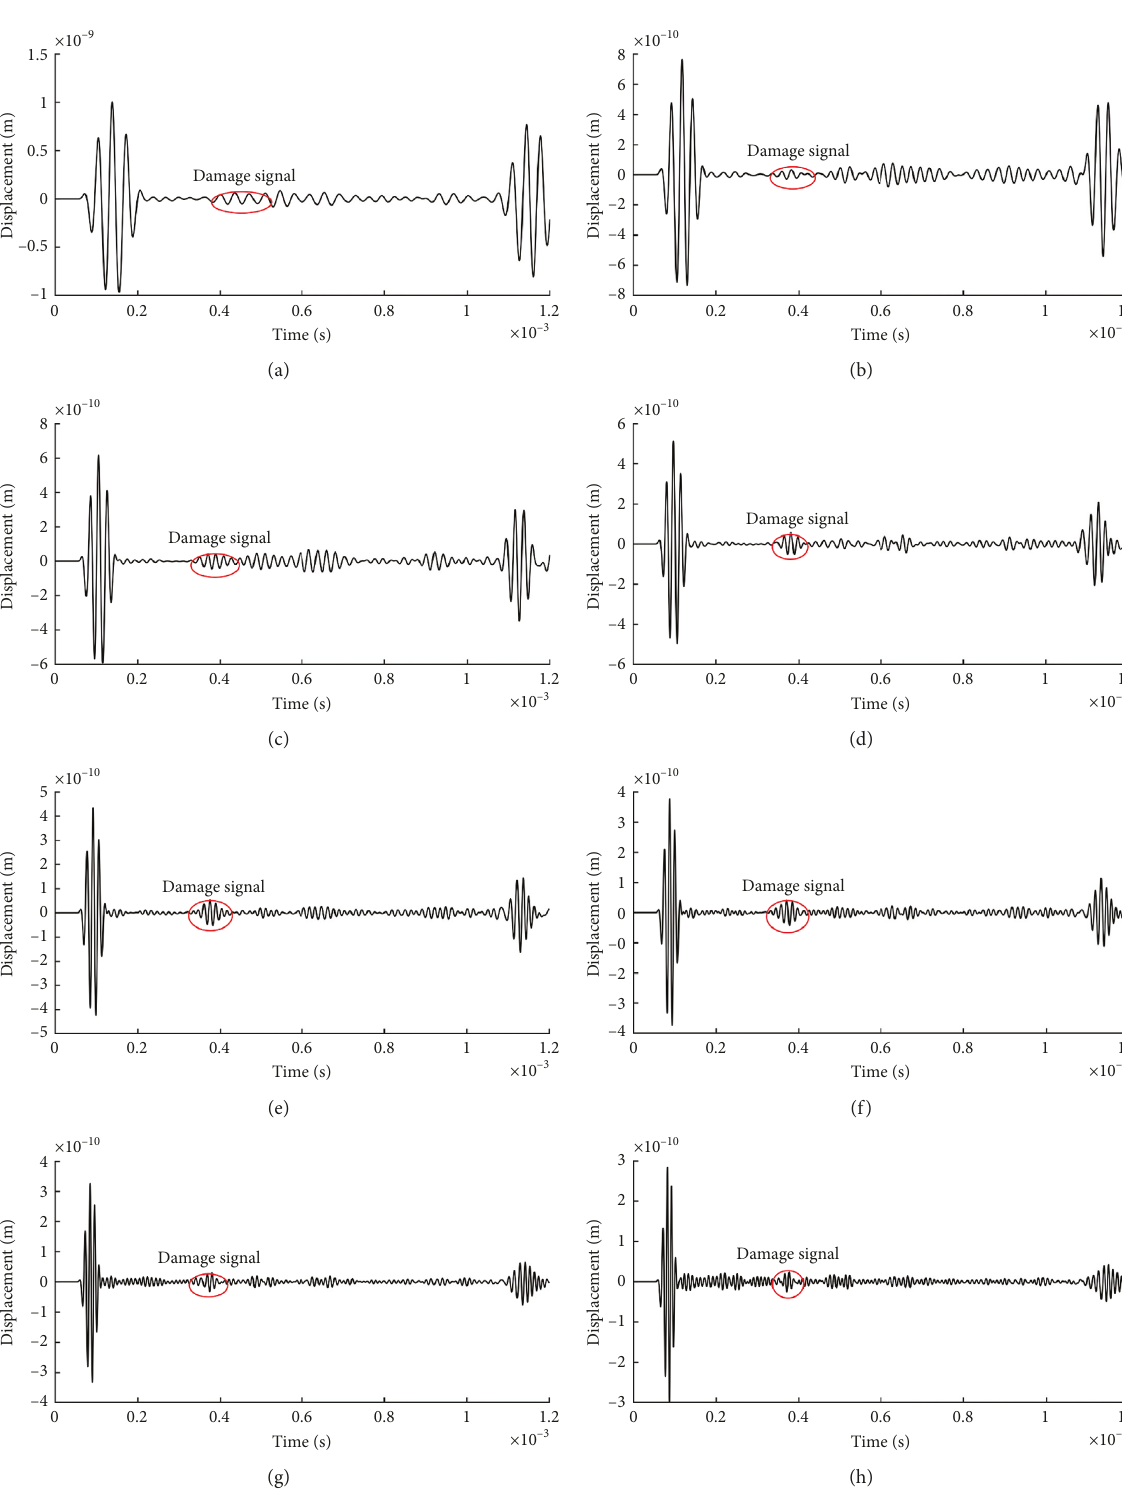
Figure 6: Time domain diagram of guided waves in single-defective sections at different excitation frequencies. (a) 30kHz guided wave signal; (b) 40kHz guided wave signal; (c) 50kHz guided wave signal; (d) 60kHz guided wave signal; (e) 70kHz guided wave signal; (f) 80kHz guided wave signal; (g) 90kHz guided wave signal; (h) 100kHz guided wave signal of the far-end defect gradually decreases and the cylindrical guided wave propagation is inversely gradually approaches the amplitude of the reflected echo proportional to the square of the distance. As the relative signal of the near-end defect. distance decreases, the amplitude of the reflected echo